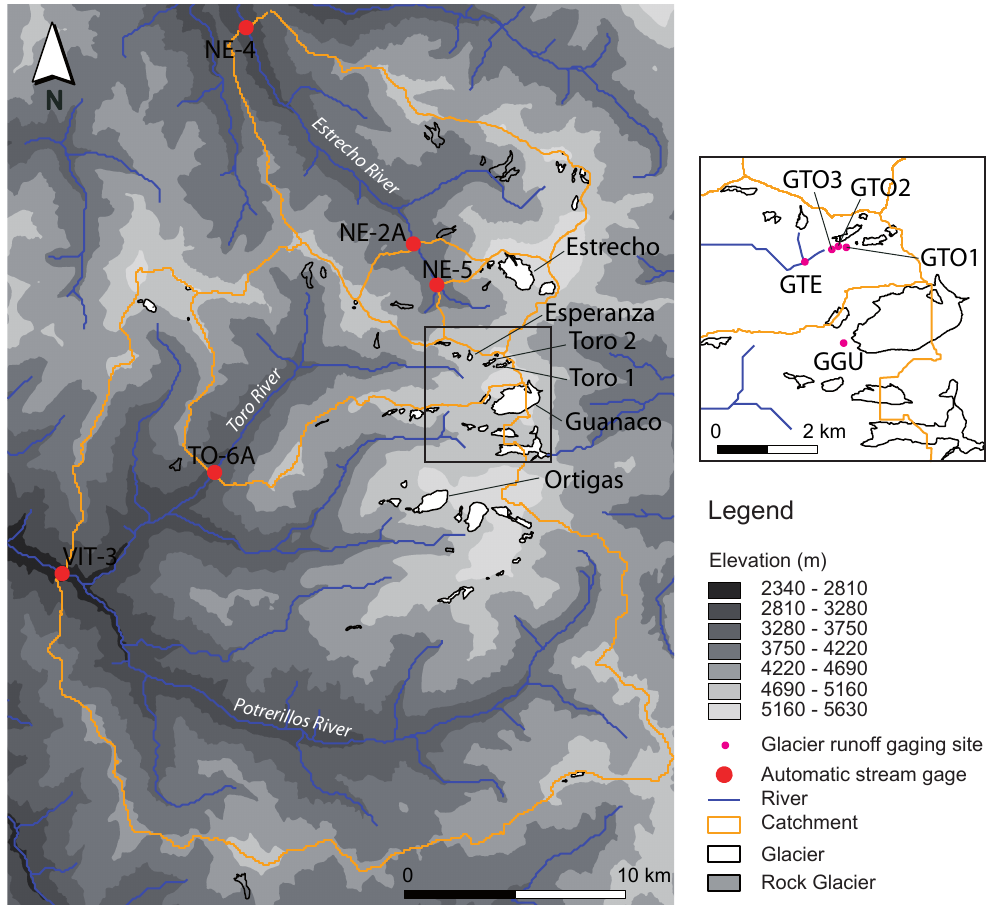
Fig. 1. Map of the study